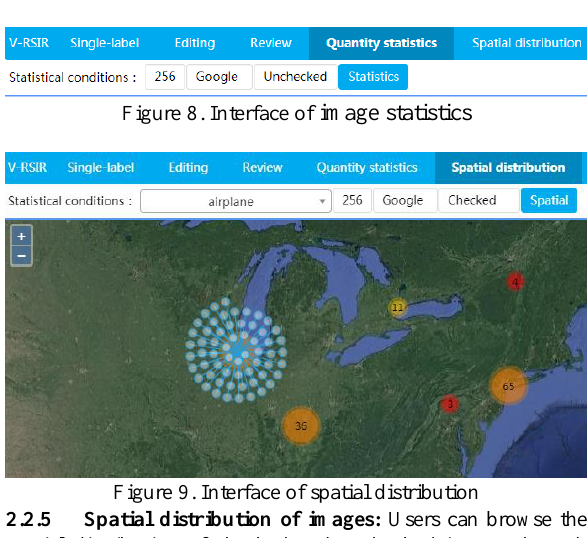
Figure 4. Interface of cropping images